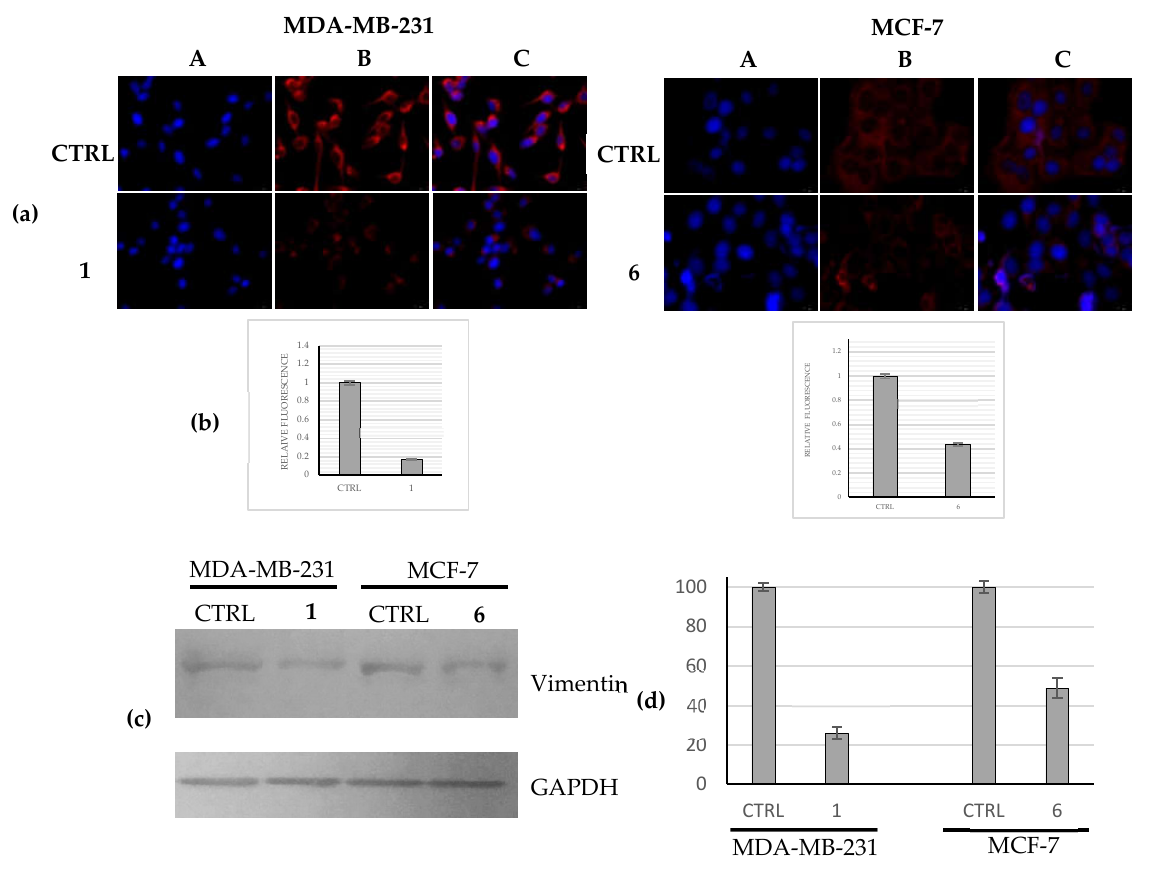
Figure 6. Evaluation of vimentin expression levels. ( a ) Immunofluorescence studies: MDA-MB-231 and MCF-7 cells were treated with compounds 1 and 6, respectively, (used at their IC 50 values) or with a vehicle (CTRL) for 24 h. After treatment, the cells were further processed, observed and imaged under the inverted fluorescence microscope at 40 × magnification (for more details see Materials and Methods). Compound 1 induced a downregulation of the vimentin expression with respect to the CTRL cells in MDA-MB-231 cells. Panels A: nuclear stain with DAPI ( λ ex / λ em = 350/460 nm); Panels B: vimentin (Alexa Fluor ® 568; λ ex /λ em = 644/665 nm); Panels C: show a merge. Images are representative of three separate experiments; ( b ) Fluorescence quantification carried out using ImageJ; *** p < 0.001; ( c ) Western blots analysis: MDA-MB-231 and MCF-7 cells were treated with compounds 1 and 6, respectively, (used at their IC 50 values) or with a vehicle (CTRL) for 24 h and then the total protein content was extracted and processed as reported in the Experimental Section. GAPDH: loading normalization. Images are representative of three separate experiments; ( d ) Western blots quantification carried out using ImageJ; *** p < 0.001.